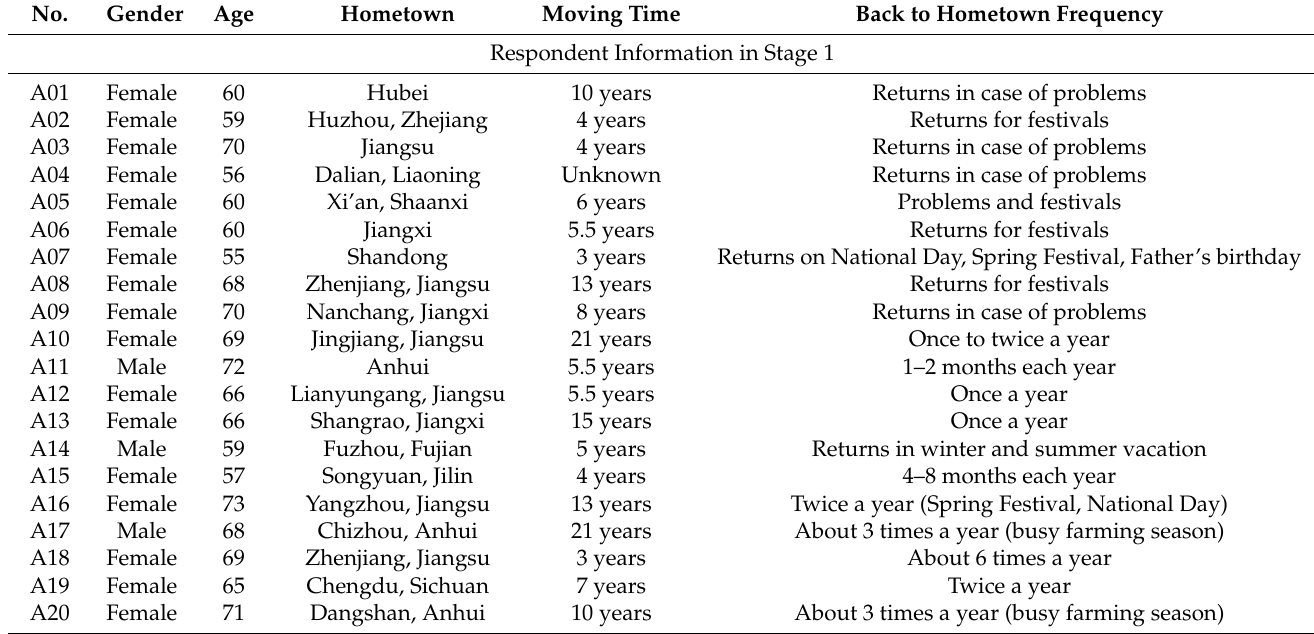
Table 2. Profile of the interviewed migrating